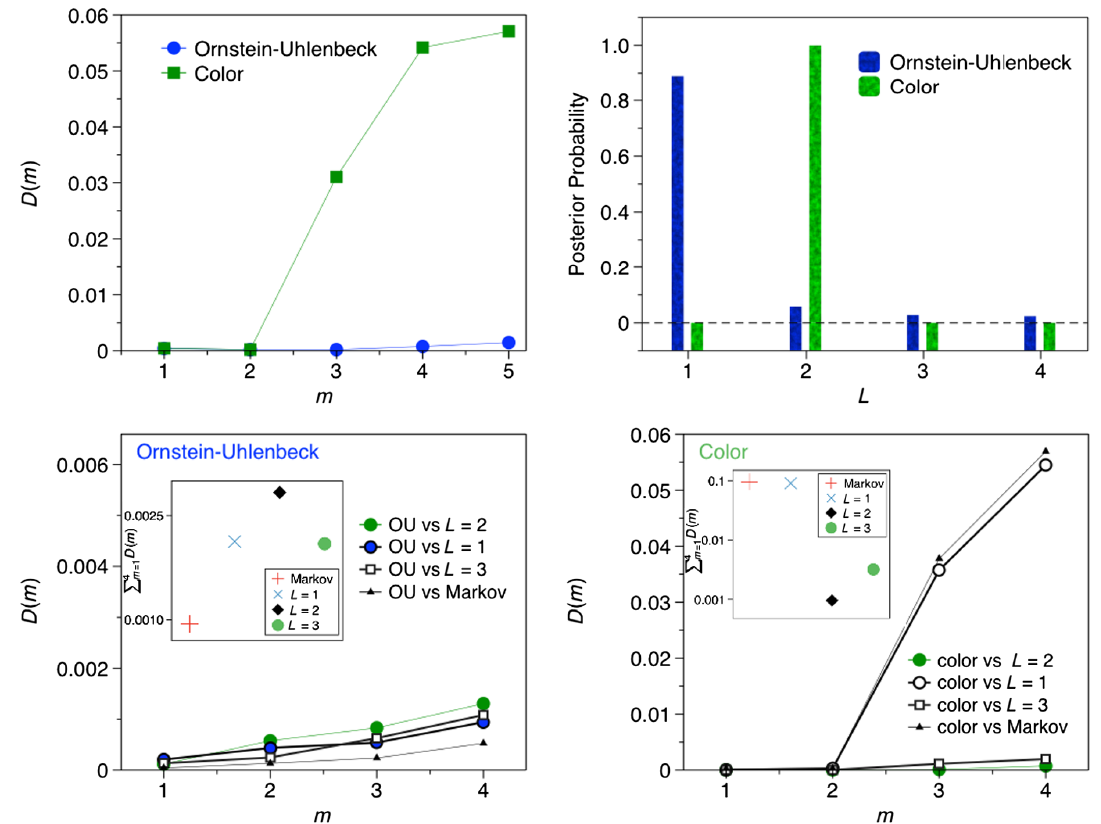
FIG. 4. (Top-left panel) Multiplexity detection statistic D ð m Þ , applied to a trajectory generated by (blue) an Ornstein-Uhlenbeck process (Markovian, see the text) and (green) a Langevin equation with colored noise (non-Markovian, see the text) after embedding the trajectories in a ring topology via Eq. (4). The multiplexity detection is negative in the Markovian case and positive for the Langevin equation with a nonwhite noise term, as expected. (Top-right panel) Posterior probability of a multiplex model with L layers, confirming that L ¼ 1 (i.e., monoplex) is the most probable model for the Markovian case (Ornstein-Uhlenbeck) and that a model with L ¼ 2 is the most likely model for the case of a Langevin equation with correlated noise. (Bottom-left panel) D ð m Þ (order-m Kullback Leibler divergence) between the Ornstein-Uhlenbeck (Markovian) process and a synthetic series generated by the most likely model with L layers (for L ¼ 1 , 2, 3). Estimation of the model parameters (the architecture) is possible thanks to the importance sampling procedure, which preselects parameter configurations with high likelihood, in such a way that one can find the global optimum by searching in this reduced set. The synthetic series that shows the highest similarity with the original process is found for the model L ¼ 1 (only improved by the comparison with a Markovianized time series) coinciding with the prediction found by the model selection scheme. (Bottom-right panel) Similar measures as the left panel, performed on the series extracted from the Langevin equation with colored noise (non-Markovian). In this case, the synthetic series that shows more similarity with the actual non-Markovian series is the one generated by the most likely model with L ¼ 2